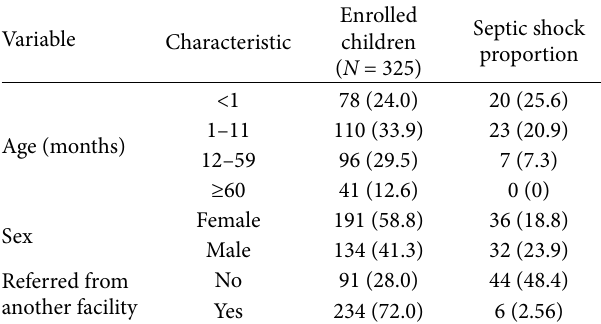
Figure 1: Study flow chart. 325 children were enrolled and 50 children were audited with septic shock. Table 1: Sociodemographic characteristics of enrolled children and those diagnosed with septic